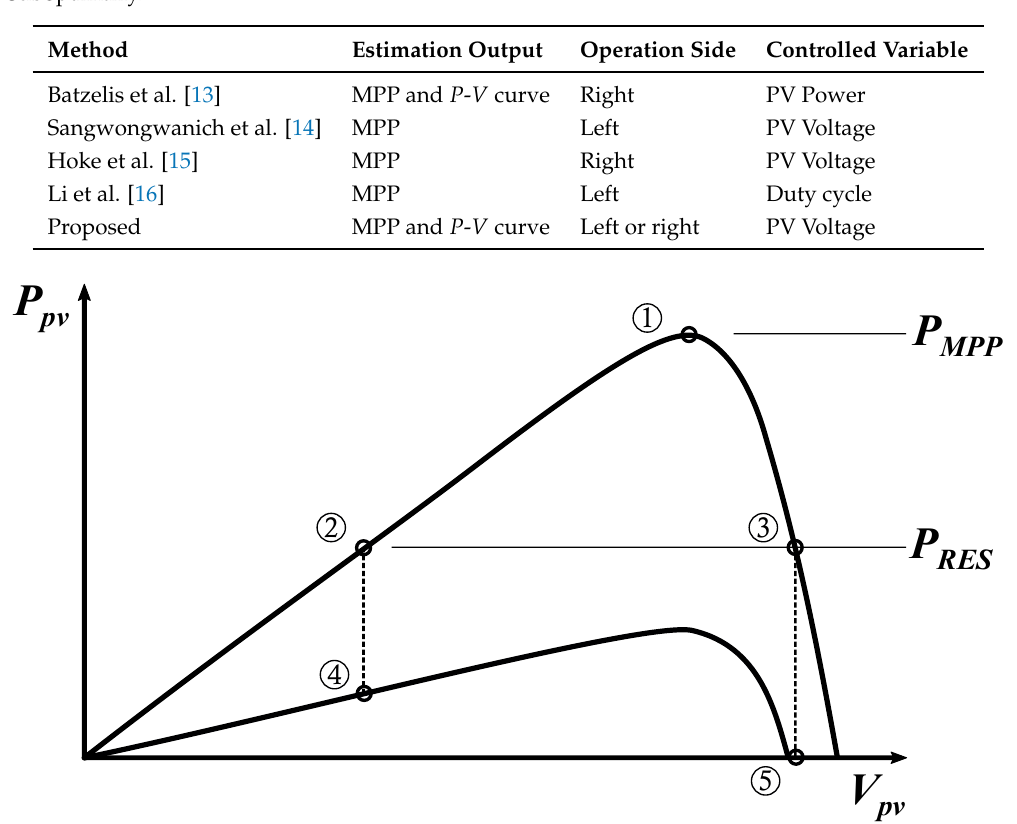
Table 1. Existing and proposed methods for estimating environmental conditions while operating suboptimally.